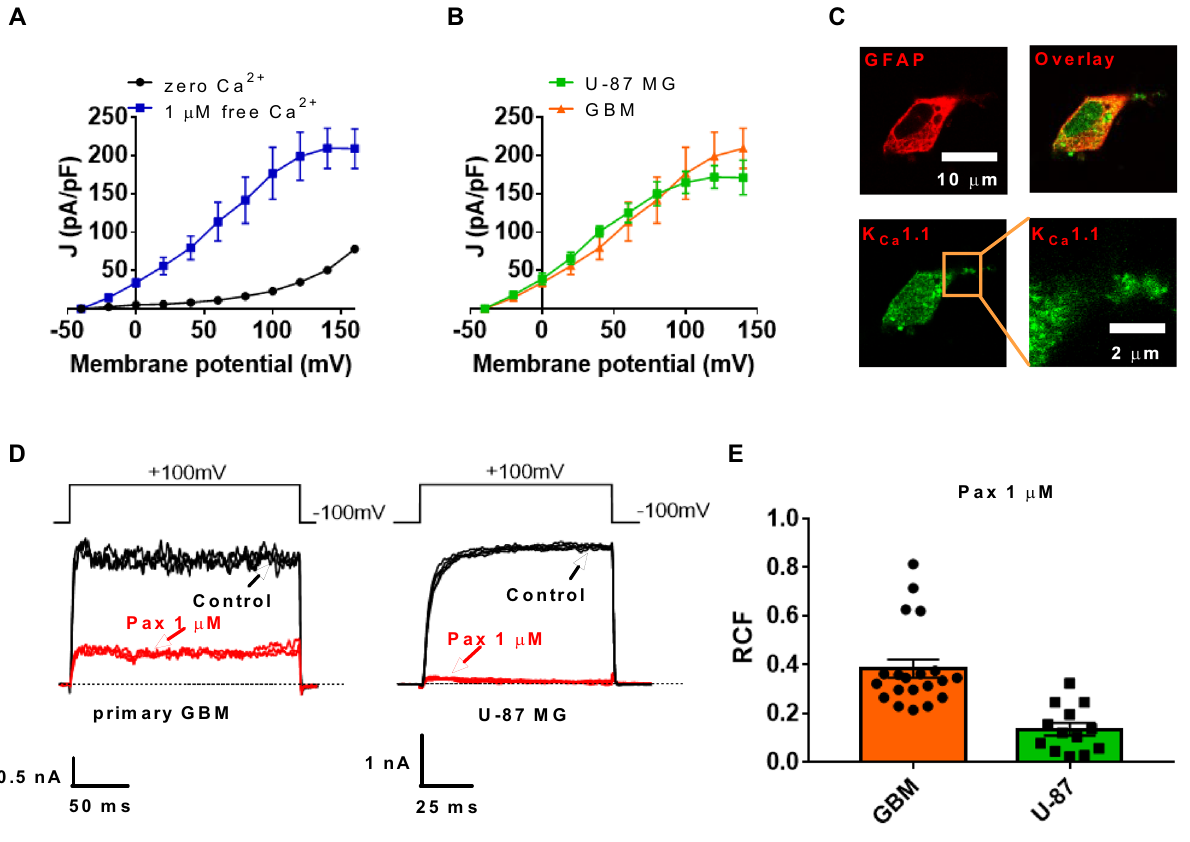
Figure 1. K Ca 1.1 is a key K + ion channel in glioblastoma cell membrane Current density–voltage relationship of whole-cell currents in primary glioblastoma cells. Current densities (J, pA/pF) at the indicated membrane potentials were calculated by dividing the peak current by the cell membrane capacitance. Data were obtained with intracellular solutions containing zero Ca 2+ (black, n = 11) or 1 µM Ca 2+ (blue, n = 5). ( B ) Current density– voltage relationship of whole-cell currents in primary glioblastoma cells (GBM, orange, n = 5) and in the U-87 MG glioblastoma cell line (U-87, green, n = 5). ( C ) Confocal microscopic images of a primary GBM cell. GFAP (top left) was labeled with anti-mouse Alexa 555, the K Ca 1.1 alpha subunit was labeled with anti-rabbit Alexa 647, the overlay of the two images is in the top right. The bottom right panel depicts the punctate staining pattern of K Ca 1.1 at higher magnification. ( D ) Representative whole-cell current traces recorded in a primary glioblastoma cell (GBM, left) and in a U-87 MG cell (U-87 MG, right). Currents were evoked by repeated depolarizations to + 100 mV from a holding potential of -100 mV (see voltage pulse above the raw current traces) every 15 s in control extracellular solution (black) and upon reaching equilibrium block in the presence of 1 µM paxilline (red). The pipette filling solution contained 1 µM Ca 2+ concentration. ( E ) Remaining current fractions (RCF = I/I 0 , where I 0 and I are the peak currents in the absence and in the presence of the inhibitor, respectively) of the outward currents in primary glioblastoma (GBM, orange bar) and U-87 MG cells (green bar) in the presence of 1 µM paxilline. Black symbols indicate RCF values obtained in individual cells. Throughout the figure, data points, bars and error bars are mean ± SEM for the indicated number of